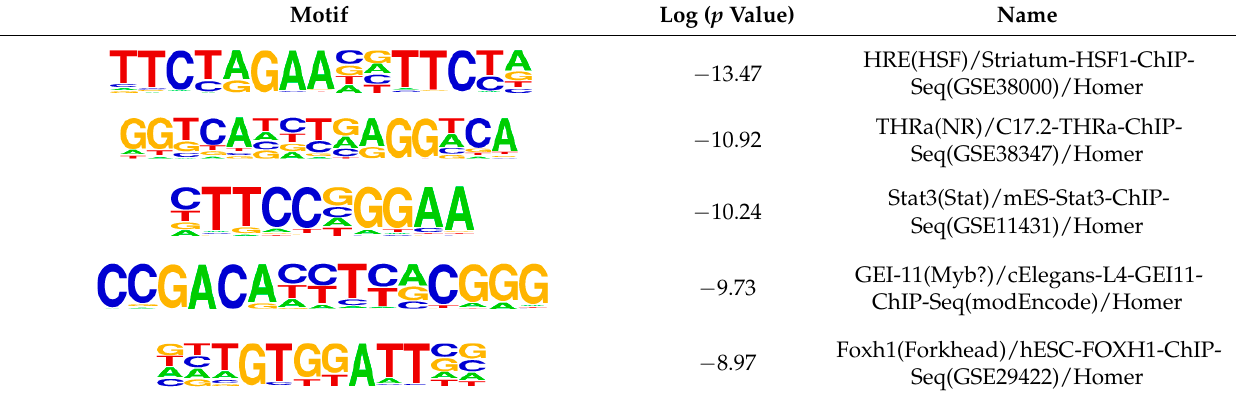
Table 5. HOMER enrichment results for top 5 known motifs in white A. japonicus , compared with green A. japonicus .